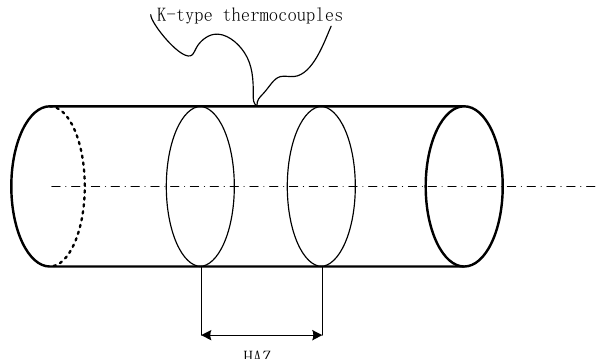
Figure 1. K-type thermocouples location.